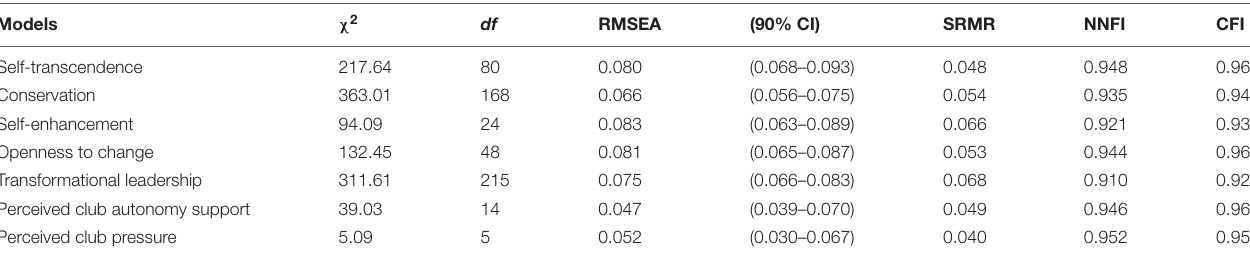
TABLE 2 | Confirmatory factor analyses: goodness of fit indices for all study instruments.